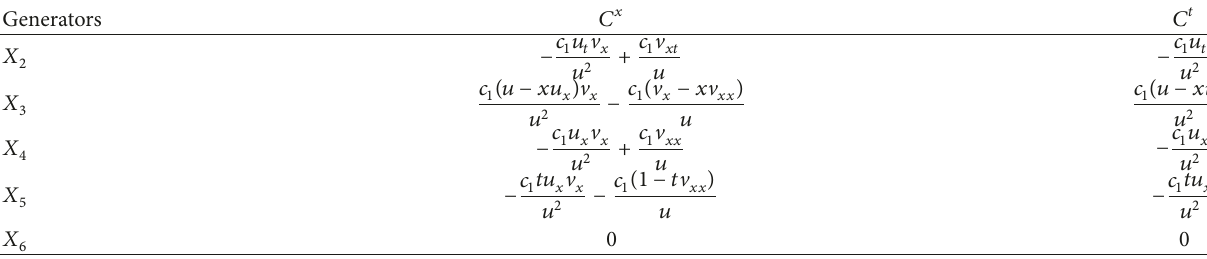
Table 4: Conservation laws of the two-component Chaplygin gas